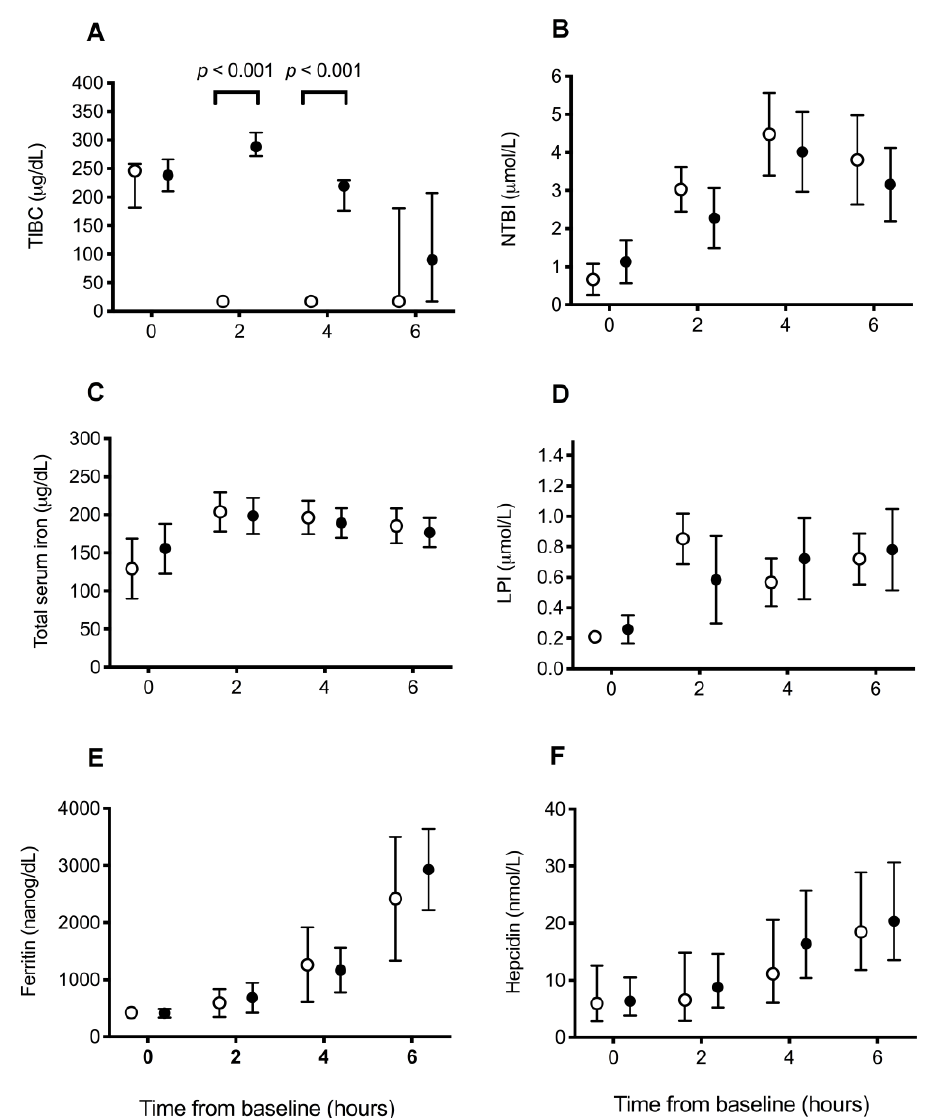
Figure 2. Blood iron parameters in dogs receiving saline or deferoxamine at baseline and 2 hourly intervals after atraumatic hemorrhage and allogenic red blood cell transfusion. Mean (95% CI) of ( A )) total iron-binding capacity (TIBC), ( B ) non-transferrin-bound iron (NTBI), ( C ) total serum iron, ( D ) labile plasma iron (LPI), ( E ) ferritin, and ( F ) hepcidin in dogs receiving saline (control: ○ , n = 10) or deferoxamine (treatment: ● , n = 10). Between baseline and 2 h, all dogs had 900 mL of whole blood removed, had 15 mL/kg of allogenic, stored, packed red blood cells transfused over 20 min, and then received 20 mL of saline (control) or an equal volume of 13.3 mg/kg deferoxamine in saline (treatment) as a continuous intravenous infusion lasting 55